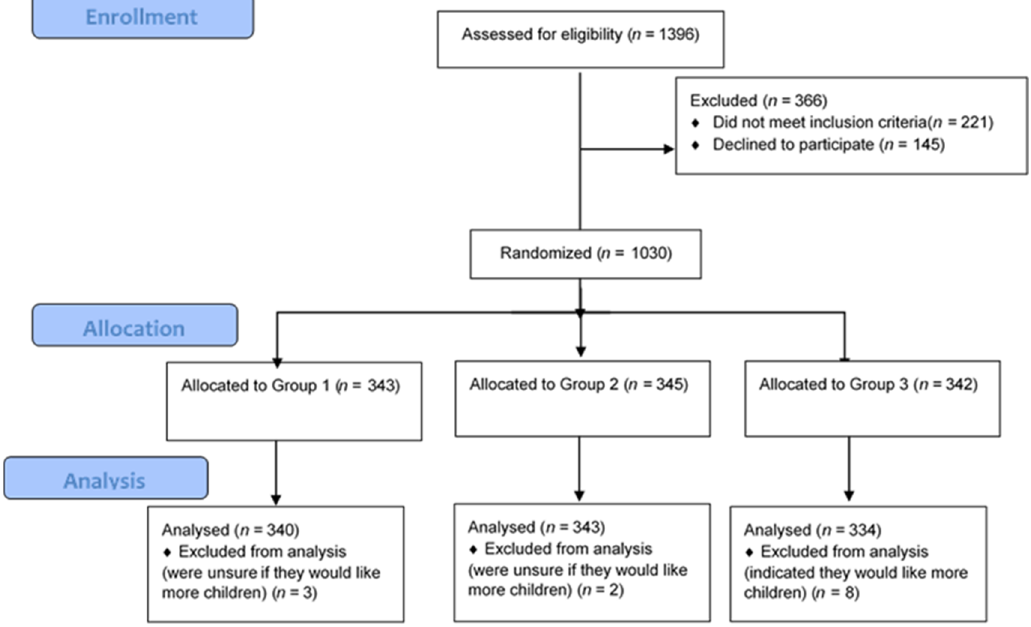
Figure 1. CONSORT 2010 Flow Diagram.